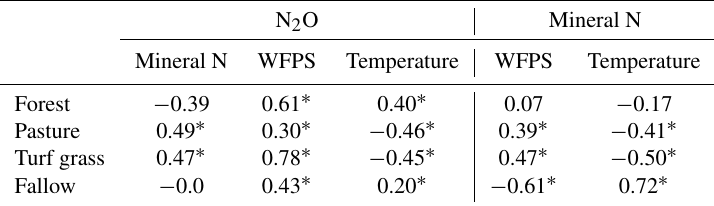
Table 4. Spearman’s rho correlation coefficient between N 2 O fluxes and mineral N, WFPS, and temperature for each treatment.